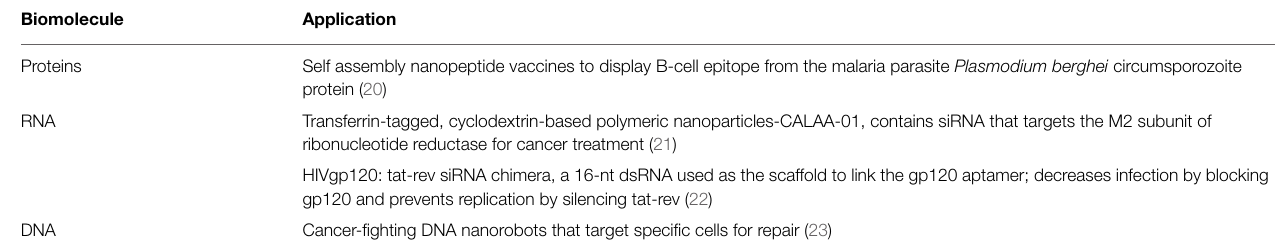
TABLE 1 | (A) Nanomedicines; (B) Propelling systems applied to nanodevices; (C) Biomolecules as nanostructures in therapeutics . (A) NANOMEDICINES AVAILABLE IN THE MARKET AND THEIR INDICATIONS Drug